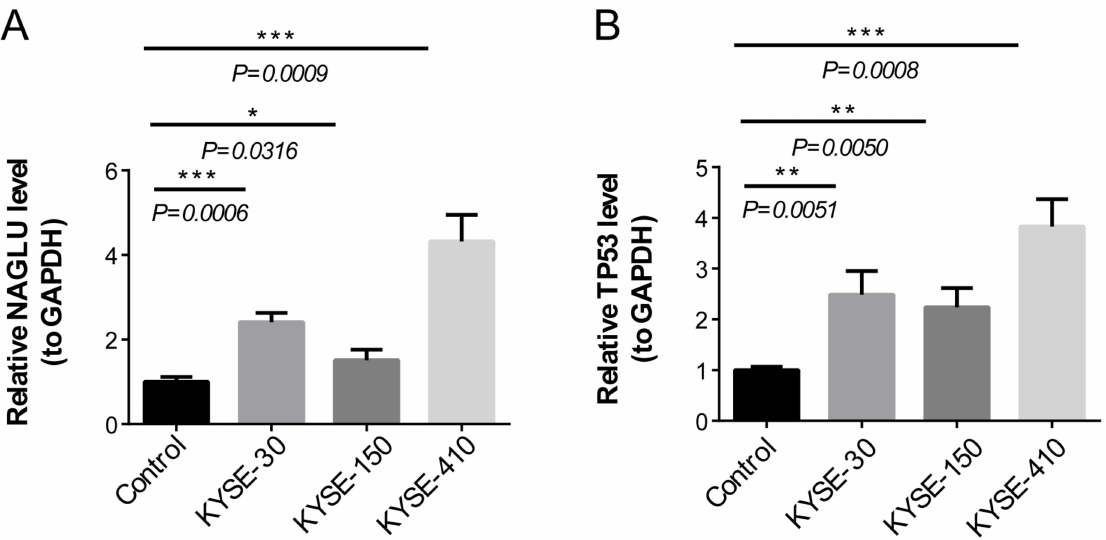
Figure 8. Comparison of differences in TP53 and NAGLU genes in KYSE-30, KYSE-150, and KYSE-410 cell lines. ( A ) The expression level of TP53 in normal cells (T-HEECs) and KYSE-30, KYSE-150, and KYSE-410 cell lines by qRT-PCR. ( B ) The expression level of NAGLU in normal cells (T-HEECs) and KYSE-30, KYSE-150, and KYSE-410 cell lines by qRT-PCR. * represents p < 0.05, ** represents p < 0.01, *** represents p < 0.001, and ns represents no significant